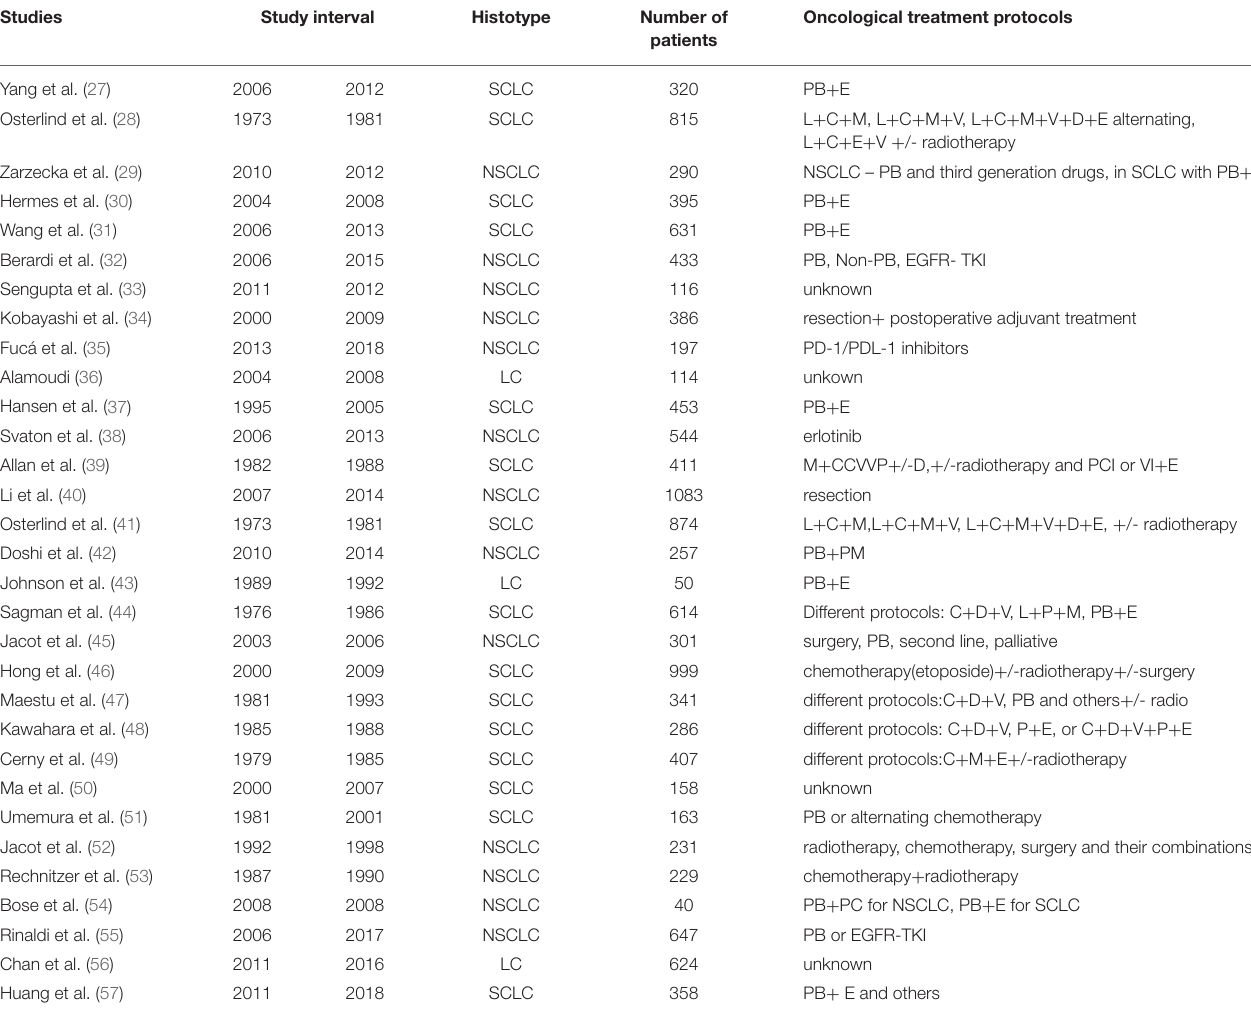
TABLE 2 | Different oncological treatment protocols in the included